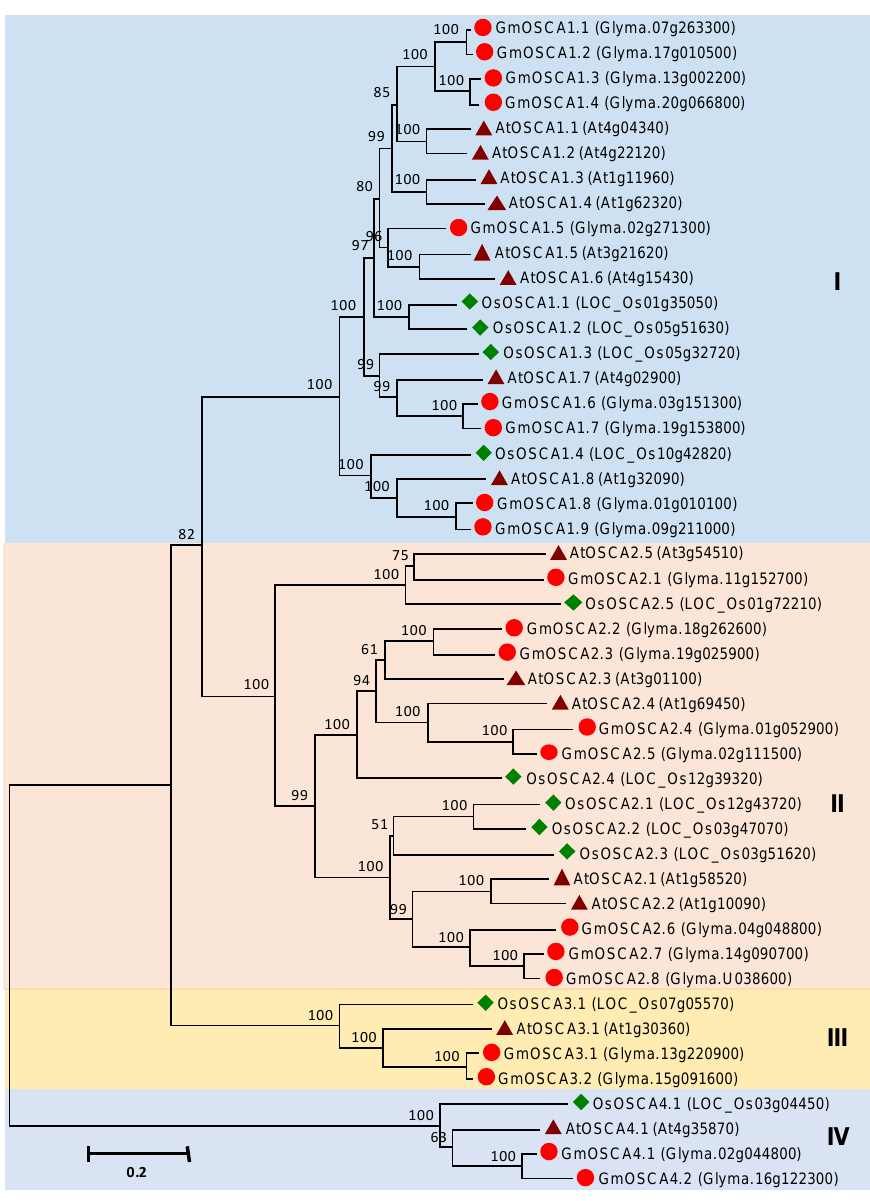
Figure 5. Unrooted phylogenetic tree of the OSCA family proteins from soybean ( Glycine max ), rice ( Oryza sativa ), and Arabidopsis thaliana . Soybean OSCAs are marked with red circles, Arabidopsis OSCAs were marked with purple triangles, while rice OSCAs were marked with green diamonds. The bar indicates the relative divergence of the sequences examined, and bootstrap values are displayed next to the branch. Roman numerals designate the subfamilies.